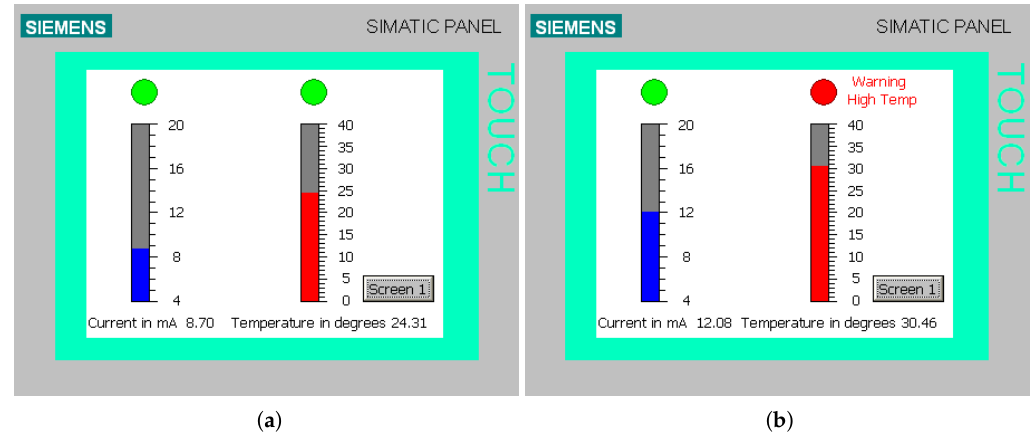
Figure 11. Image of HMI panel created in WinCC Flexible. ( a ) Temperature below 30 degrees Celsius; ( b ) Temperature above 30 degrees Celsius with the high temperature alarm